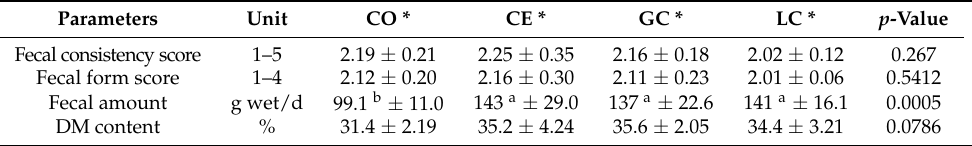
Table 3. Fecal characteristics of dogs fed diets with different fiber sources (mean ± SD).